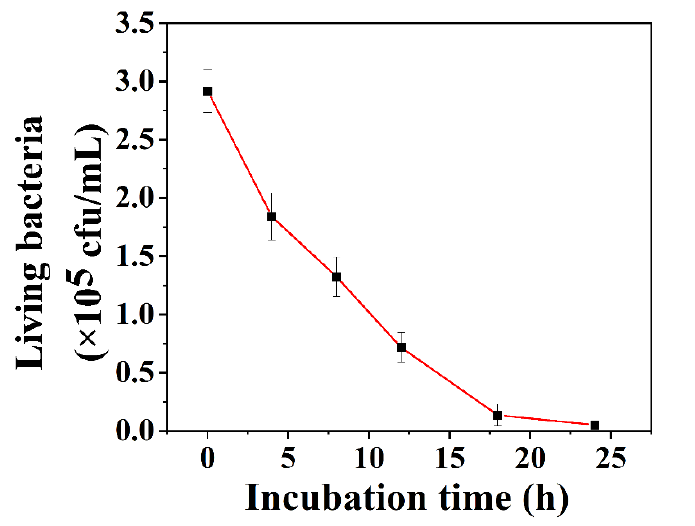
Figure 4. The change curve of living bacteria concentration after biofilm incubation with AHMSN@GA@PEI@Cur for different time (0 h, 4 h, 8 h, 12 h, 18 h, 24